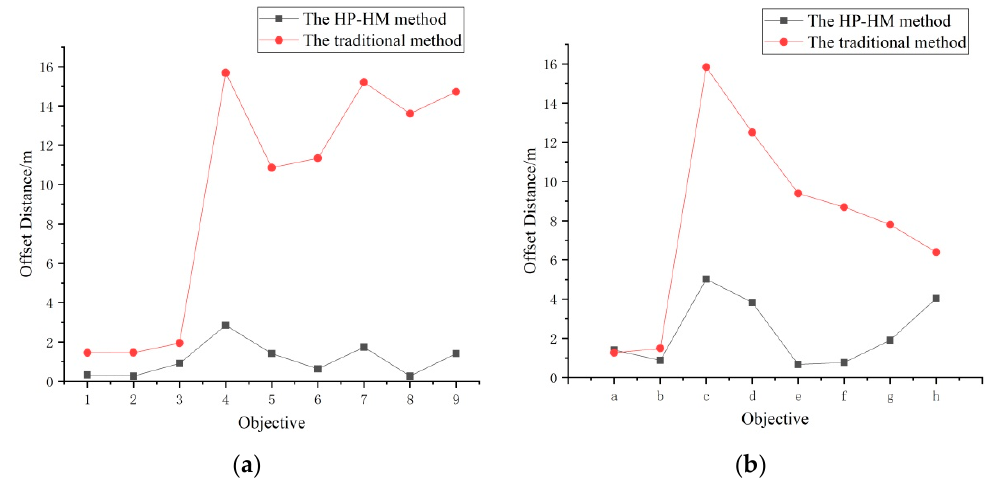
Figure 12. The object mapping deviation of different homography matrices in the parking lot: ( a ) Camera 3 and ( b ) Camera 4.